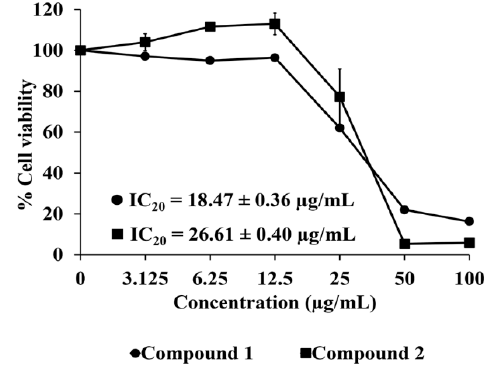
Figure 5. The effect of compound 1 and compound 2 on the viability of RAW 264.7 cell line using MTT assay. Each point represents the mean ± SD of three independent experiments performed in triplicate.